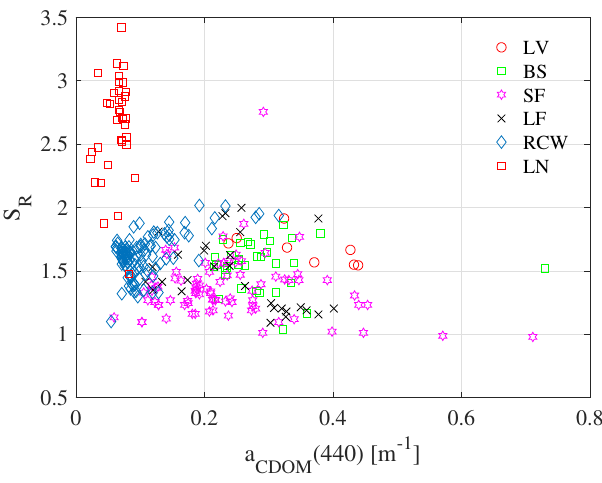
Figure 5. Scatter plot of S R ( S 280 − 295 / S 350 − 400 ) versus the CDOM absorption coefficient at 440 [ a CDOM ( 440 )